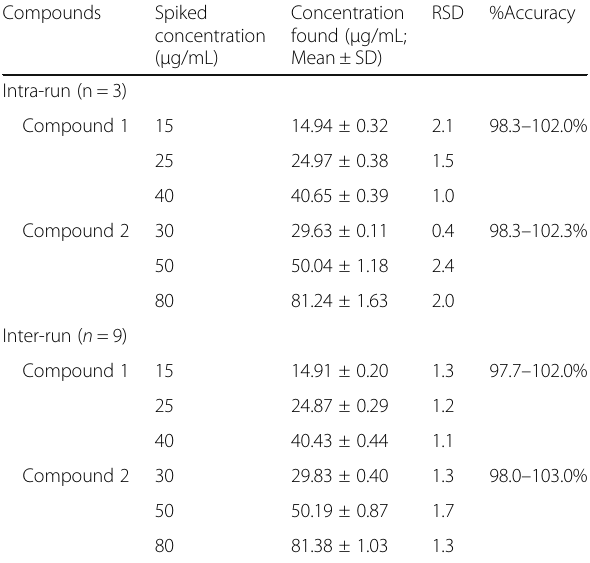
Table 5 Accuracy and precision of quantitative method for determination of compound 1 and compound 2 in ethanolic extract of root of B.montanum Compounds Spiked